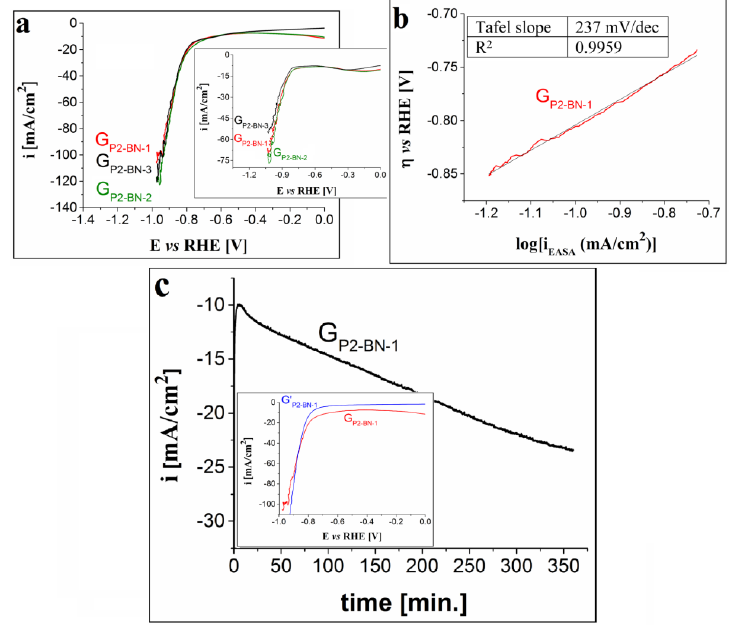
Figure 7. ( a ) Cathodic polarization curves recorded on the G P2-BN-1 , G P2-BN-2 and G P2-BN-3 electrodes in 1 M KOH solution, at v = 5 mV/s. Inset shows the voltammograms traced on the same electrodes, but in 0.1 M KOH solution. ( b ) The Tafel plot obtained for the G P2-BN-1 electrode in 1 M KOH solution. ( c ) i-time curve recorded on the G P2-BN-1 electrode in 1 M KOH solution and inset showing the LSVs traced on the electrode before and after the stability test (coded as G P2-BN-1 and G’ P2-BN-1 ).